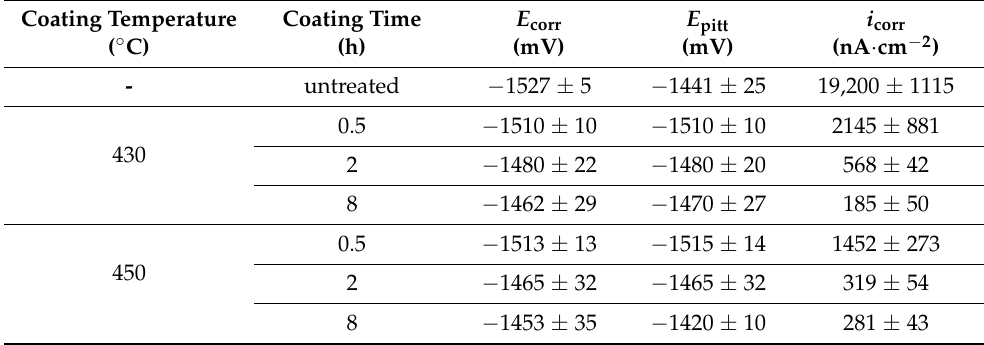
Figure 6. Polarization curves of AZ31 alloy without and with the fluoride conversion coatings prepared at 430 and 450 ◦ C. Table 3. Determined electrochemical characteristics of the untreated and coated AZ31 magnesium